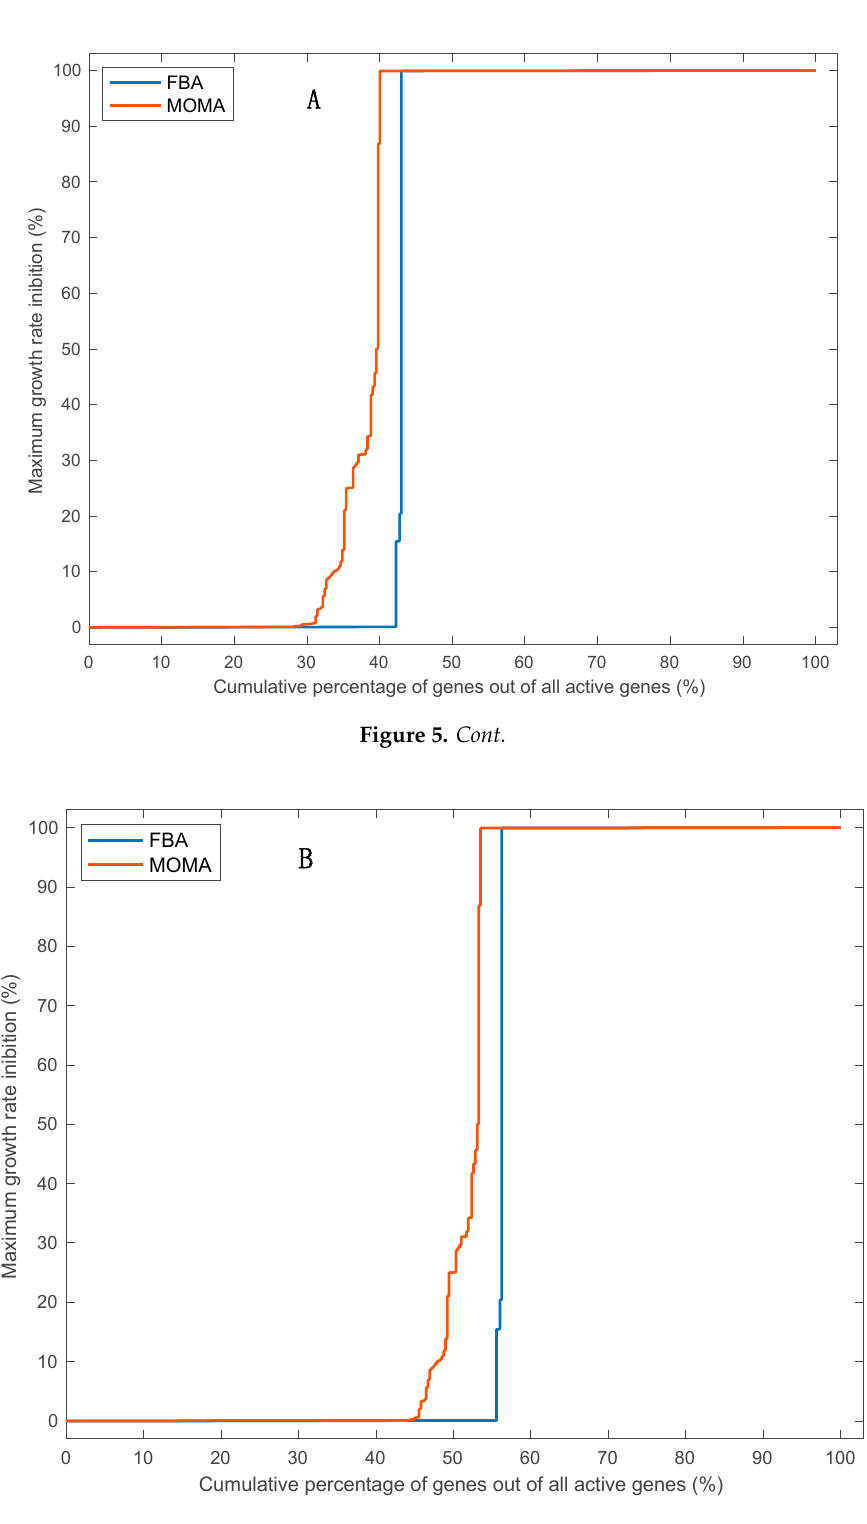
Figure 5. Cumulative percentage of active genes, for which deletion of each reaction (taken independently), decrease the growth rate by a proportion equal to the value on the Y-axis or lower. Calculation of intracellular flux distribution and growth rate after single gene deletion were done using flux balance analyses (FBA, blue line) or quadratic minimization of metabolic adjustment (MOMA, red line). The gene deletion analysis was performed without ( A ) or with ( B ) 53 allelic variants.